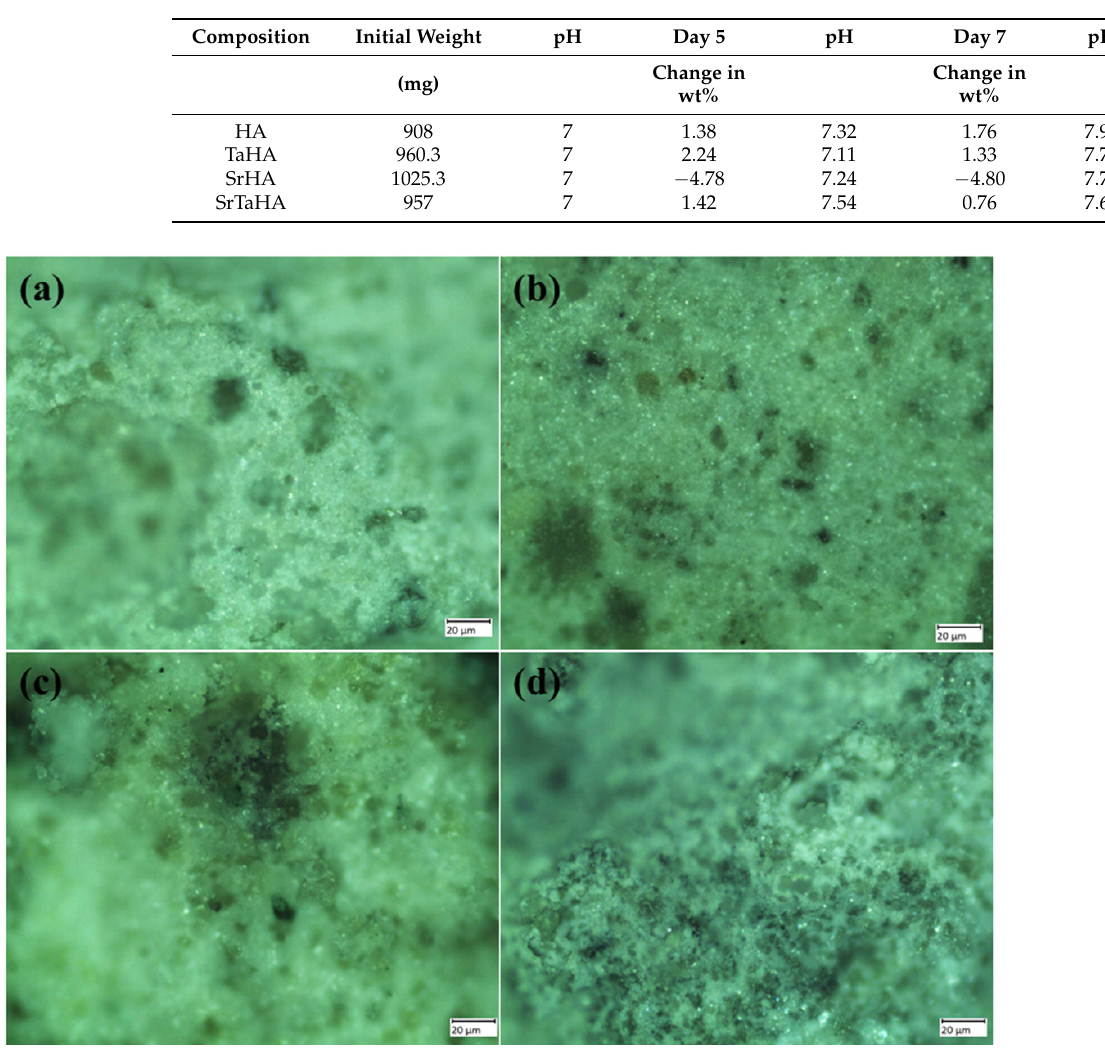
Figure 12. Optical micrographs of the ( a ) HA, ( b )TaHA, ( c ) SrHA, and ( d ) SrTaHA samples after end day point.